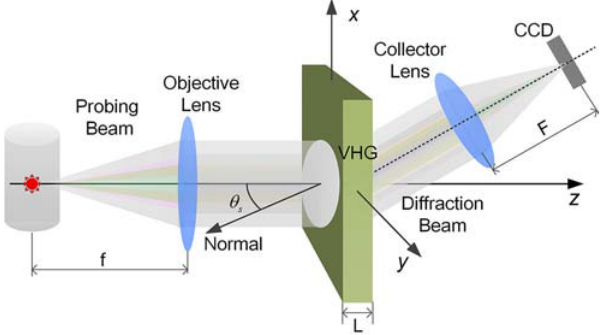
Fig. 3. Schematic of the 4F transmission geometry VHI sys- tem. L is the thickness of the VHG, f and F are the focal length of the objective lens and the collector